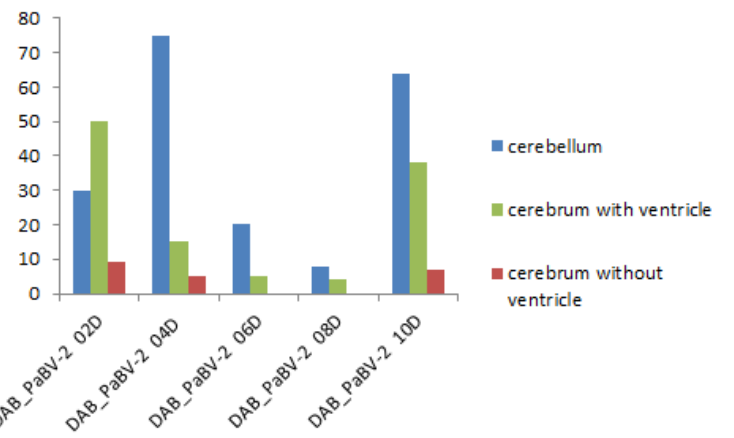
Figure 6. Parrot bornavirus (PaBV) antigen distribution in the brain trial B group 3 (PaBV-2 inoculation in the yolk sac). The y -axis shows the number of PaBV antigen-positive cells counted in one slide (200 × total magnification). The PaBV antigen distribution is similar to trial B groups 1 and 2. There was no significant difference between the cerebrum with and without ventricles. The x -axis shows each individual embryo ( n = 5, laboratory number).